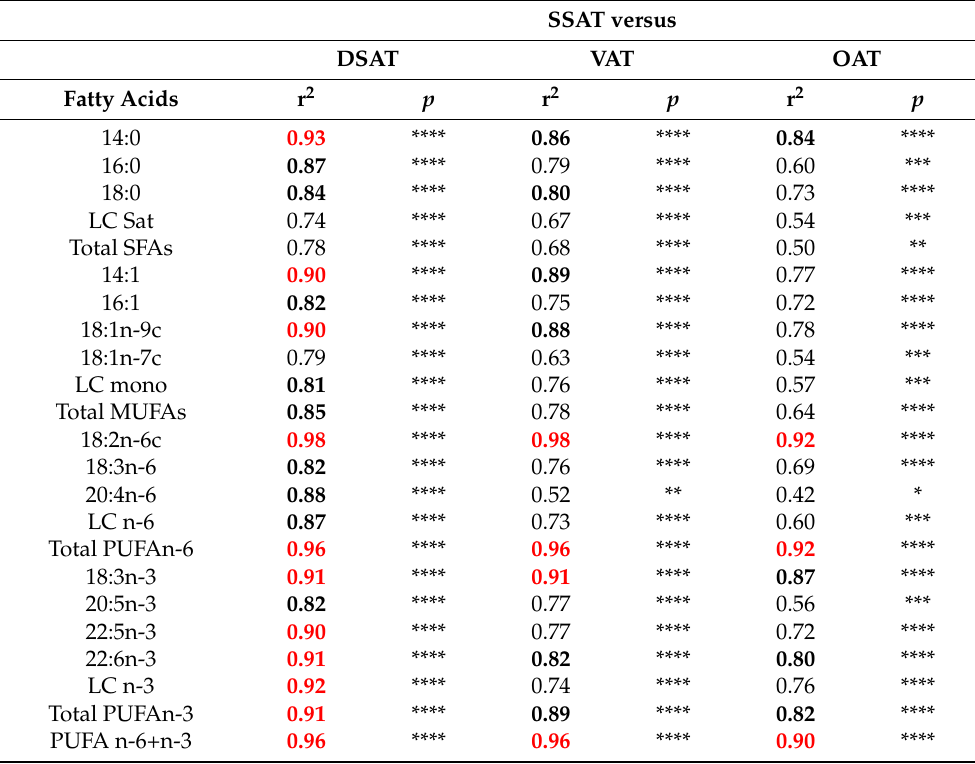
Table 4. Spearman correlation between fatty acid content in superficial subcutaneous adipose tissue versus other abdominal adipose tissues in 34 EOC patients (with two subcutaneous and two visceral